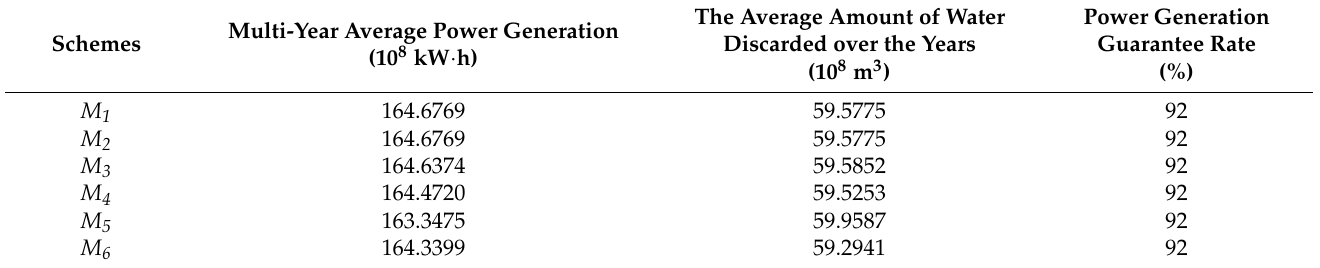
Table 2. Scheduling results table based on an eco-friendly reservoir scheduling